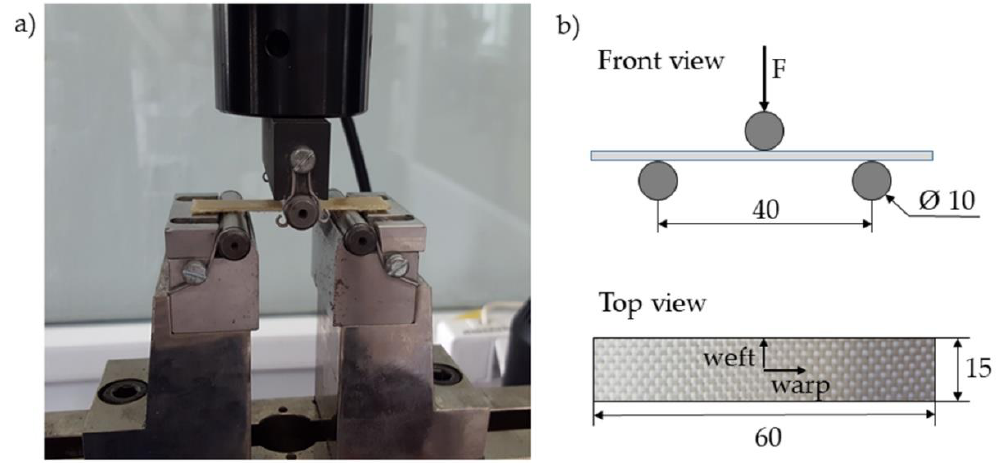
Figure 3. Flexural test setup ( a ) and schematic diagram of bending test fixture with specimen size (in mm), orientation (warp, weft) and applied force (F) ( b ).